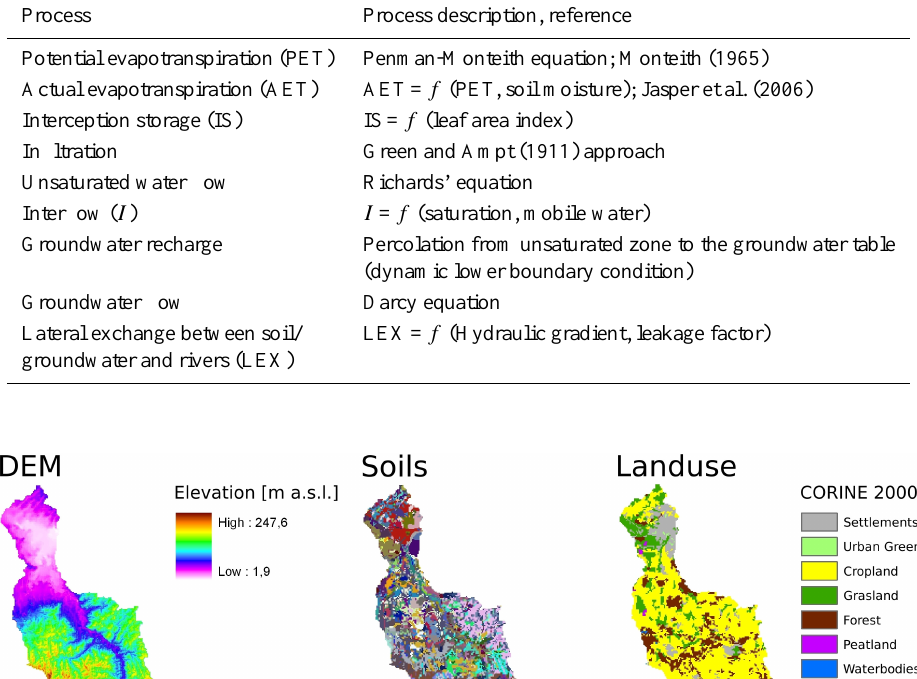
Table 1. Hydrological processes and process descriptions in WaSiM-ETH. For details see Schulla (1997) and www.wasim.ch.